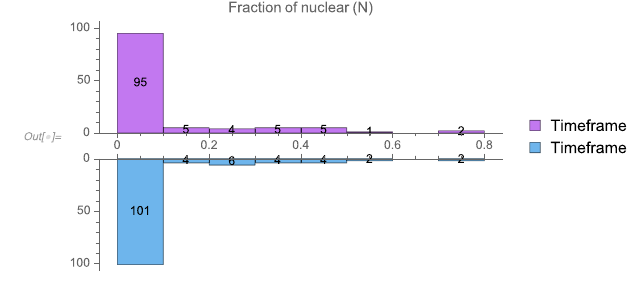
Fig. A.1. Two correlated random variables X 1 and X 2 span- Fig. A.2. Number of countries as a function of N ning plane H in L 2 ( Ω ). The projection of Y onto plane H has strictly larger R 2 than the that of the projection of Y onto either X 1 or X 2 alone. However, when expressed in ( X 1 , X 2 ) coordinates, the expression of Proj ( Y ) is misleading, since the H coordinates of this projection are large due to the fact variables X 1 and X 2 are almost collinear (in fact they are larger than those of the projection of Y onto X 1 or X 2 individually).